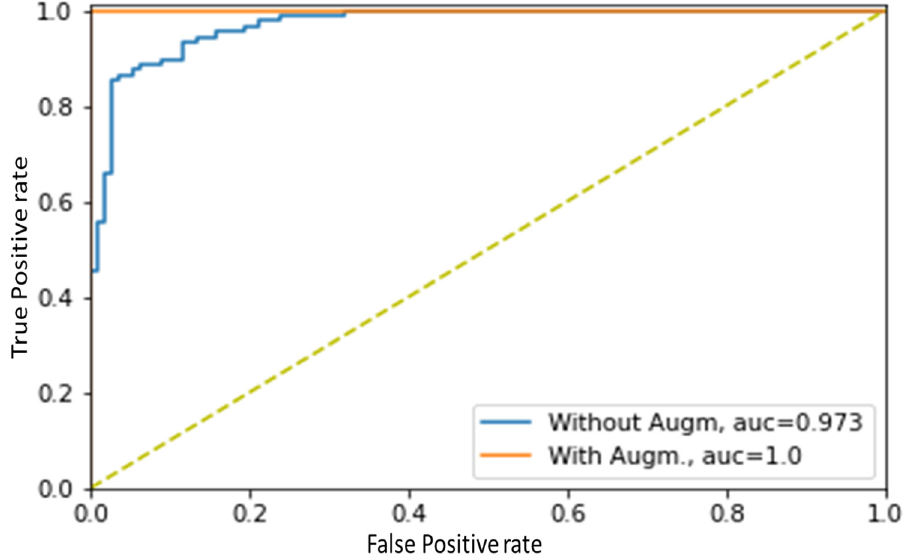
Figure 13. ROC analysis for the combination of the best-performing signal segment (5 s) and optimizer (RMSprop) are shown before and after data augmentation.